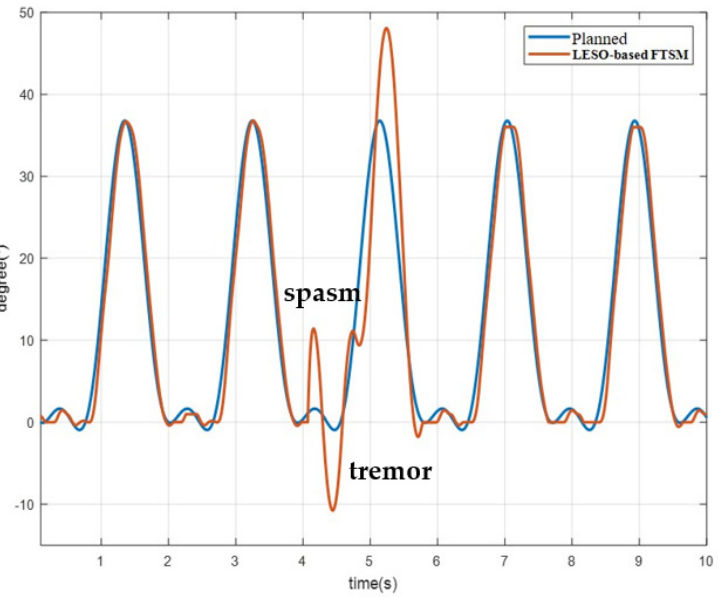
Figure 16. Trajectories of hip joint by LESO-based FTSM with spasm and tremor occurring at walking speed = 0.225 m/s.